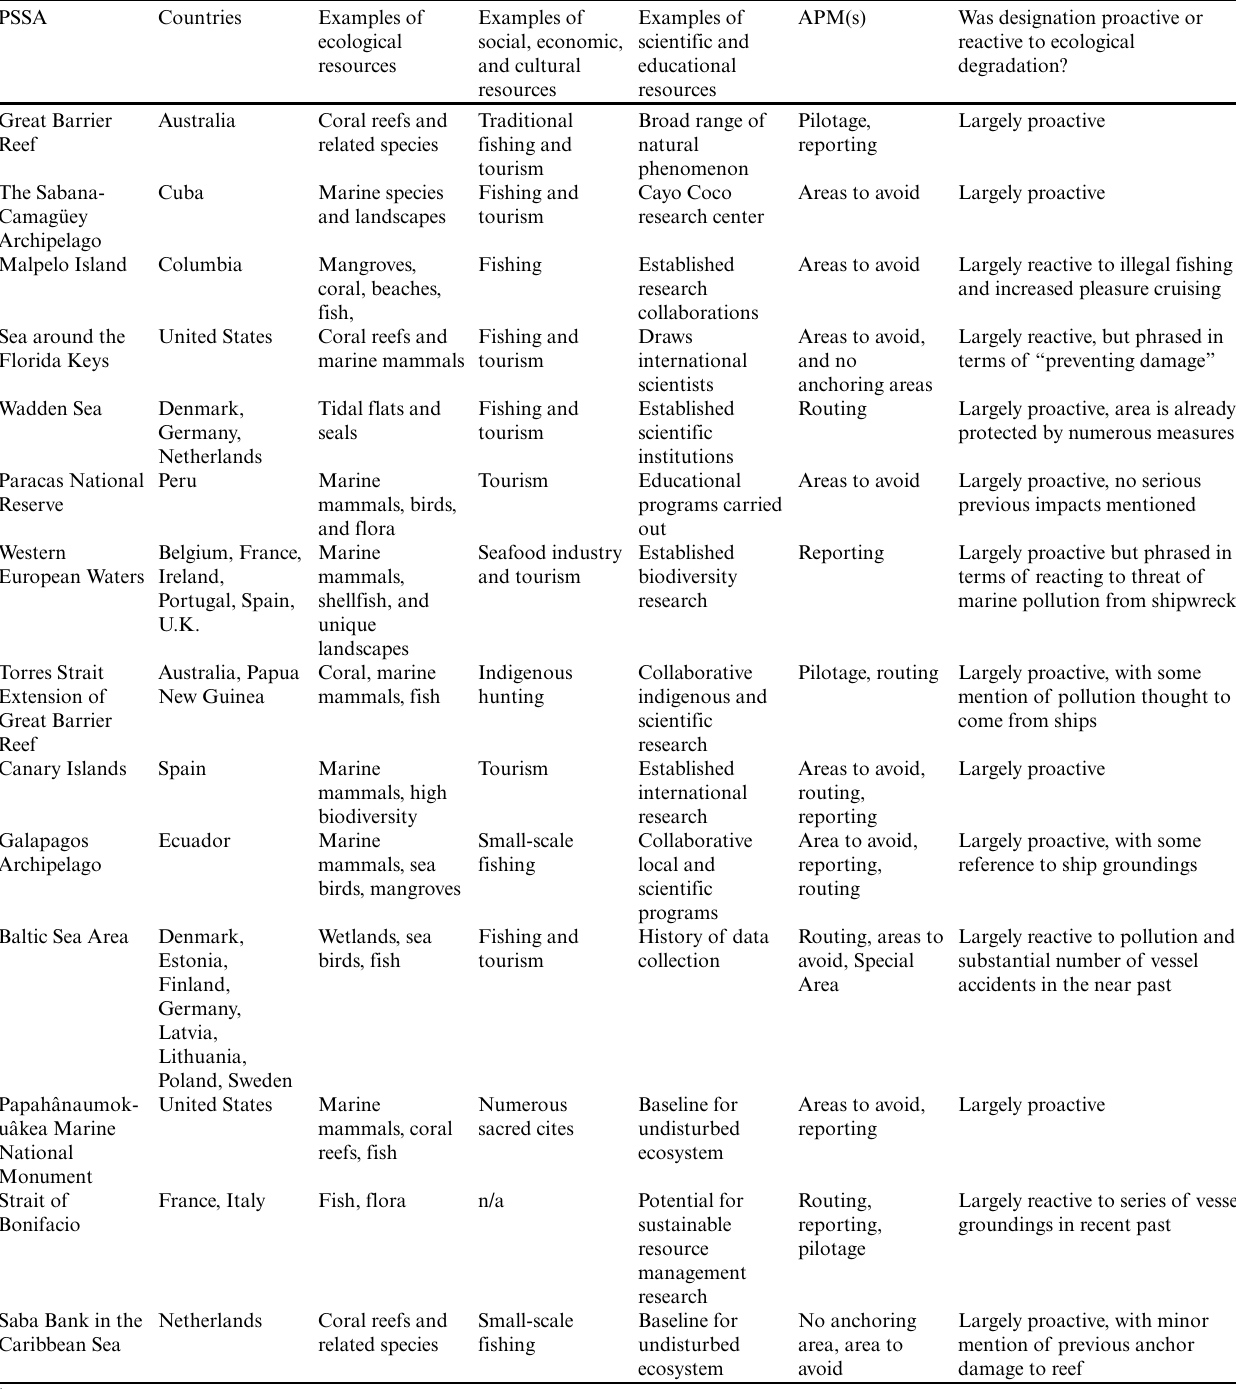
Table 1 . Existing PSSAs † and whether APMs were proactively or reactively responding to threats.